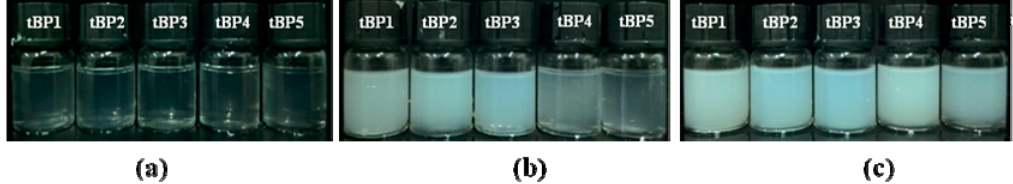
Figure 1. Photographs of the triblock copolymers aqueous solutions (2 mg·mL − 1 ) at 25 °C ( a ), 35 °C ( b ), and 45 °C ( c ).